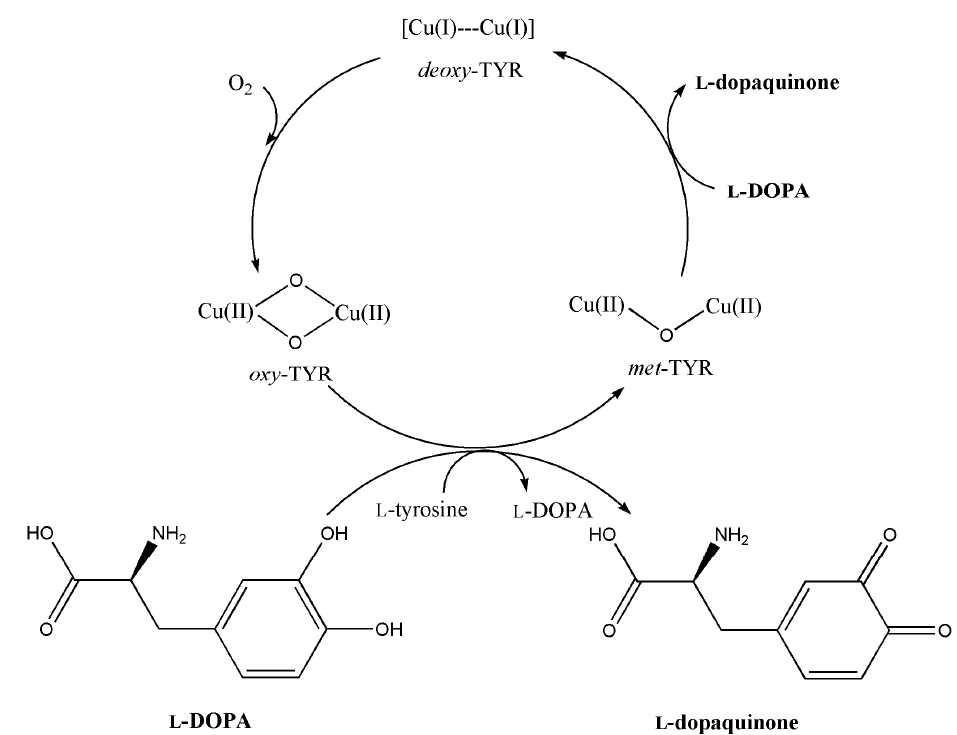
Figure 1. Schematic presentation of TYR catalysis on L -tyrosine and L -DOPA. Deoxy -TYR readily binds O 2 to form oxy -TYR, which can act as monophenolase or diphenolase depending on the substrate. The met -TYR can act only as diphenolase.